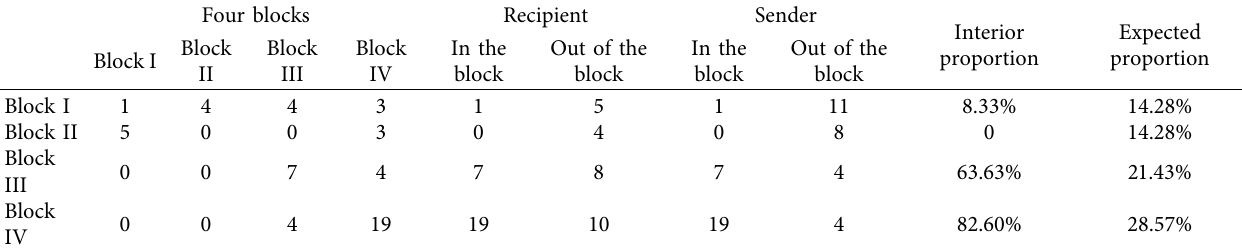
Figure 4: Clustering analysis of the trade spatial connection network. Table 2: Block model of RECP nations’ trade spatial connection